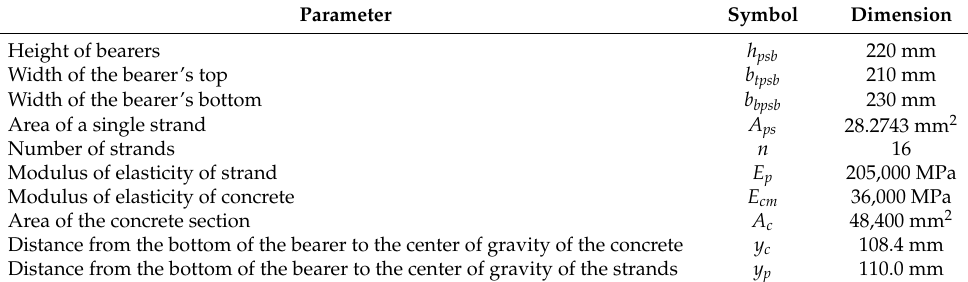
Table 1. Variables and dimensions of the bearer